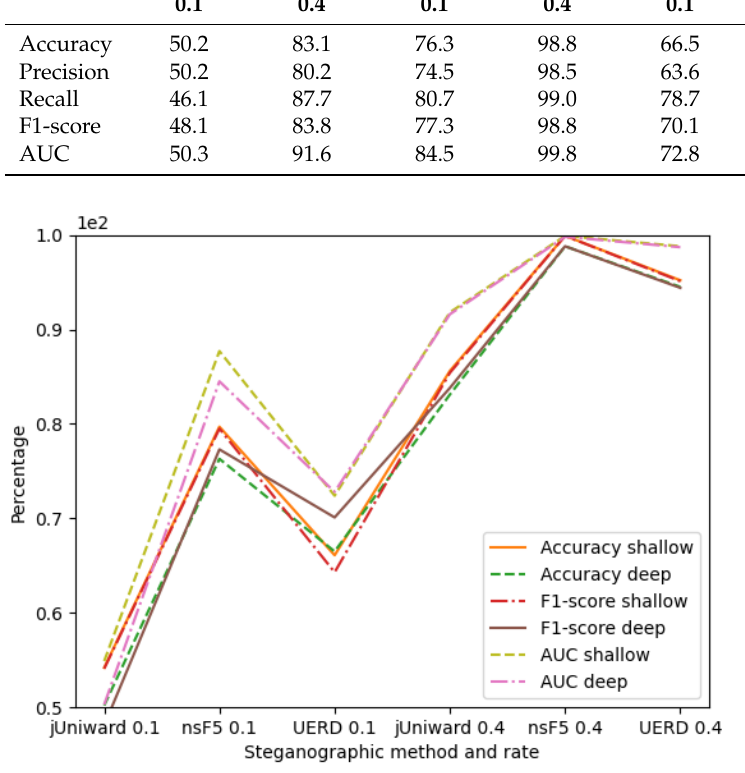
Figure 5. Visualization of evaluation results for the best shallow and deep steganalytic